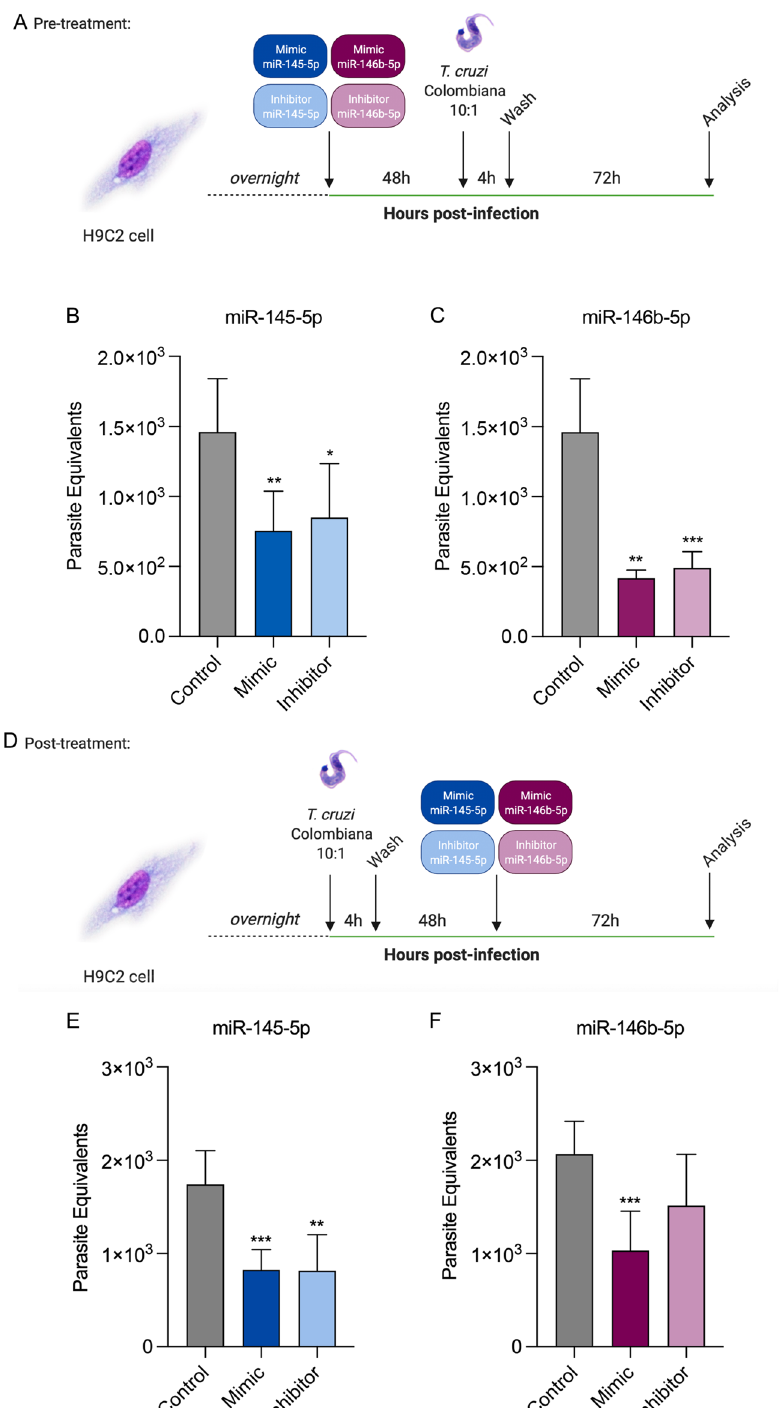
Figure 4. Pre- and post-treatment of miR-145-5p and miR-146b-5p TaqMan ® mimic/inhibitor systems alters T. cruzi infection dynamics. ( A ) H9C2 cells were pre-treated with miR-145-5p or miR-146b-5p TaqMan mimic/ inhibitor systems for 48 h, infected with T. cruzi for 4 h, washed and collected 72 h later. ( B ) Parasite load of H9C2 cells pre-treated with miR-145-5p TaqMan mimic/inhibitor system. ( C ) Parasite load of H9C2 cells pre- treated with miR-146b-5p TaqMan mimic/inhibitor system. ( D ) H9C2 cells were infected with T. cruzi for 4 h, washed, post-treated with miR-145-5p or miR-146b-5p TaqMan mimic/inhibitor systems for 48 h and collected 72 h later. ( E ) Parasite load of H9C2 cells post-treated with miR-145-5p TaqMan mimic/inhibitor system. ( F ) Parasite load of H9C2 cells post-treated with miR-146b-5p TaqMan mimic/inhibitor system. All controls are added with Lipofectamine RNAiMAX. For all graphs, significance was determined using unpaired Student’s t test or Mann–Whitney Rank Sum (*p < 0.05, **p < 0.01, ***p < 0.001). The experiment was repeated three times, using different cell culture flasks in each experimental